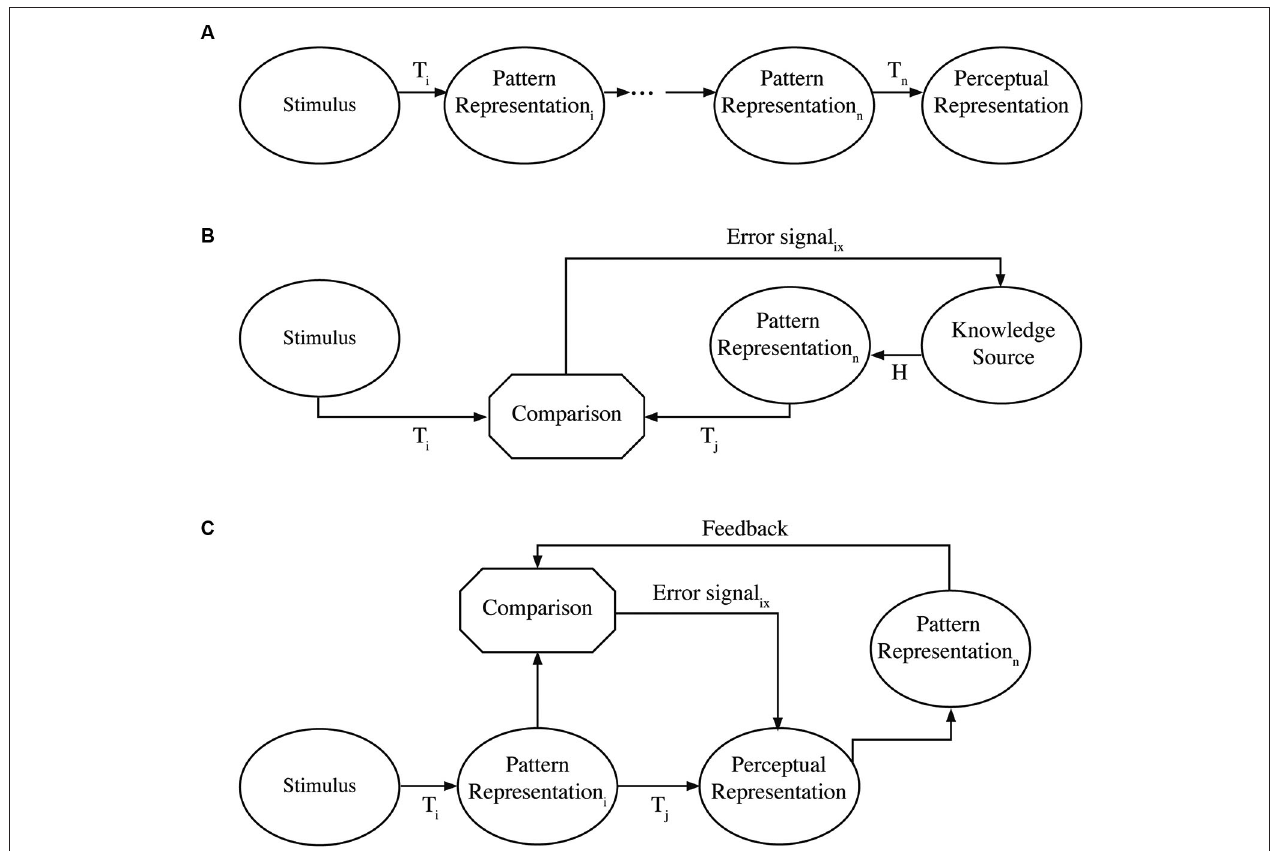
single interpretation. The generation of hypothesized patterns may be in parallel or accomplished sequentially. The bottom panel (C) represents a bottom-up active process in which sensory stimulation is transformed into an initial pattern, which can be transformed into some representation. If this representation is sensitive to the unfolding of context or immediate perceptual experience, it could generate a pattern from the immediate input and context that is different than the initial pattern. Feedback from the context-based pattern in comparison with the initial pattern can generate an error signal to the representation changing how context is integrated to produce a new pattern for comparison